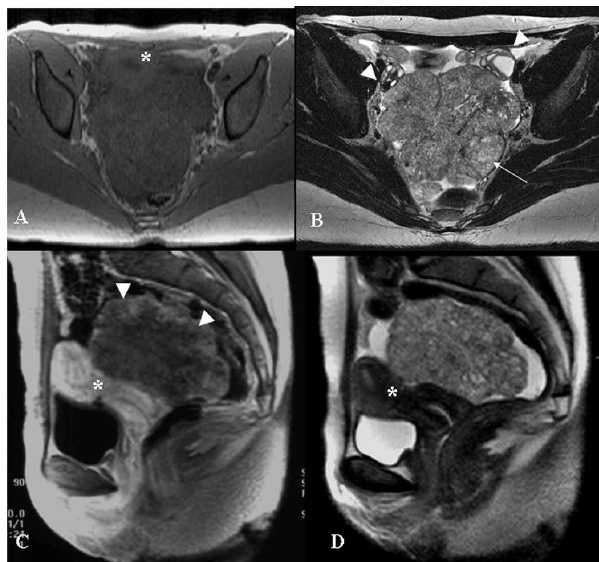
Figure 2 - Pelvic MR exam. Axial GRE T1-weighted (A), axial TSE 512 T2-weighted (B), sagittal post-contrast GRE T1-weighted image and (D) sagittal TSE T2-weighted images. There is a large, expansive, well-delimited lesion with lobulated contours; the T1-weighted sequence shows homoge- neous signal intensity predominately with a low signal, and T2-weighted sequences are heterogeneous with small high-intensity foci (arrow). The le- sion dislocated the ovaries (arrowheads, B) anterolaterally and the uterus (*, A,C and D) anteriorly. After intravenous injection of paramagnetic contrast agent, there was a heterogeneous enhancement of the lesion that was more evident peripherally (arrowheads, C)